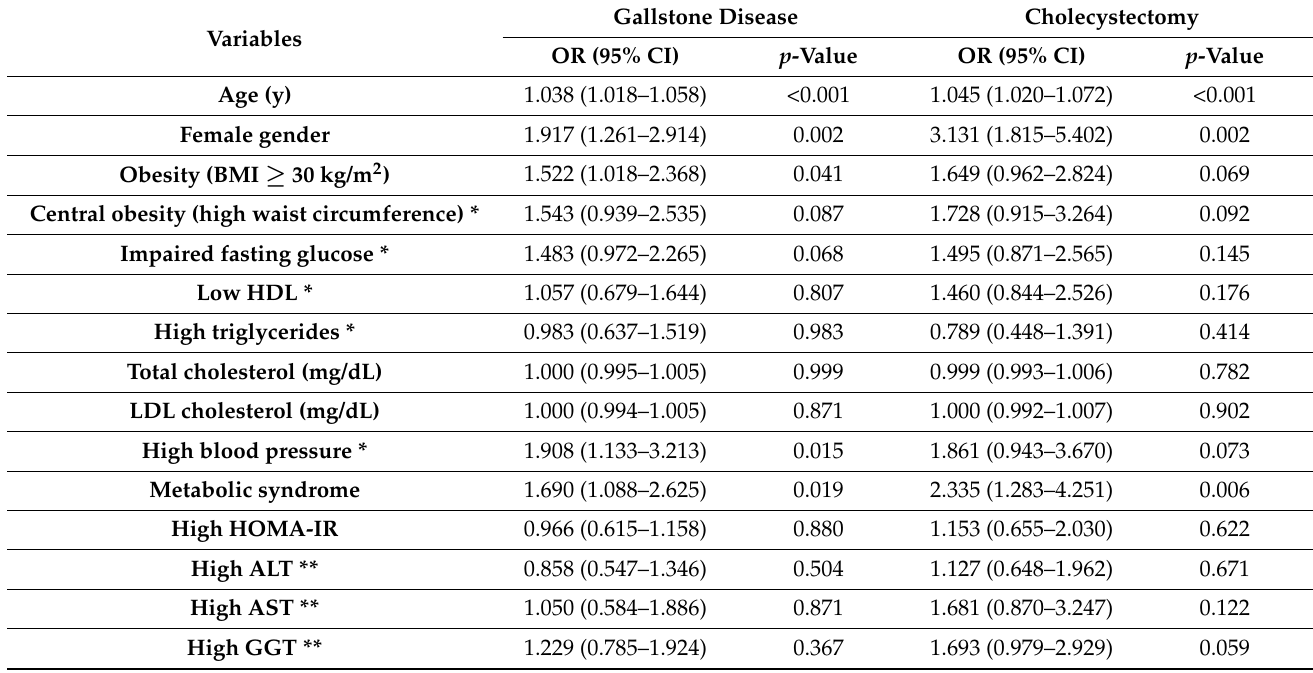
Table 2. Univariate analysis of clinical and laboratory variables associated with gallstone disease and cholecystectomy. Variables